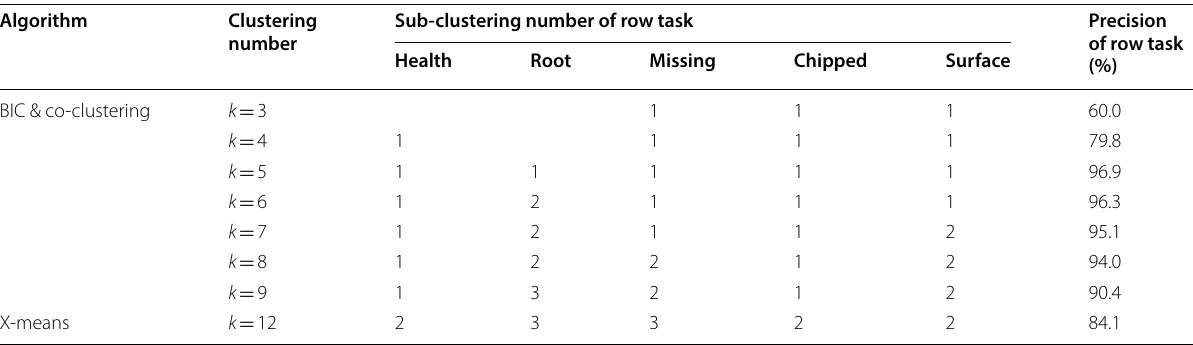
Table 9 Estimation results of X‑means and BIC algorithm Algorithm